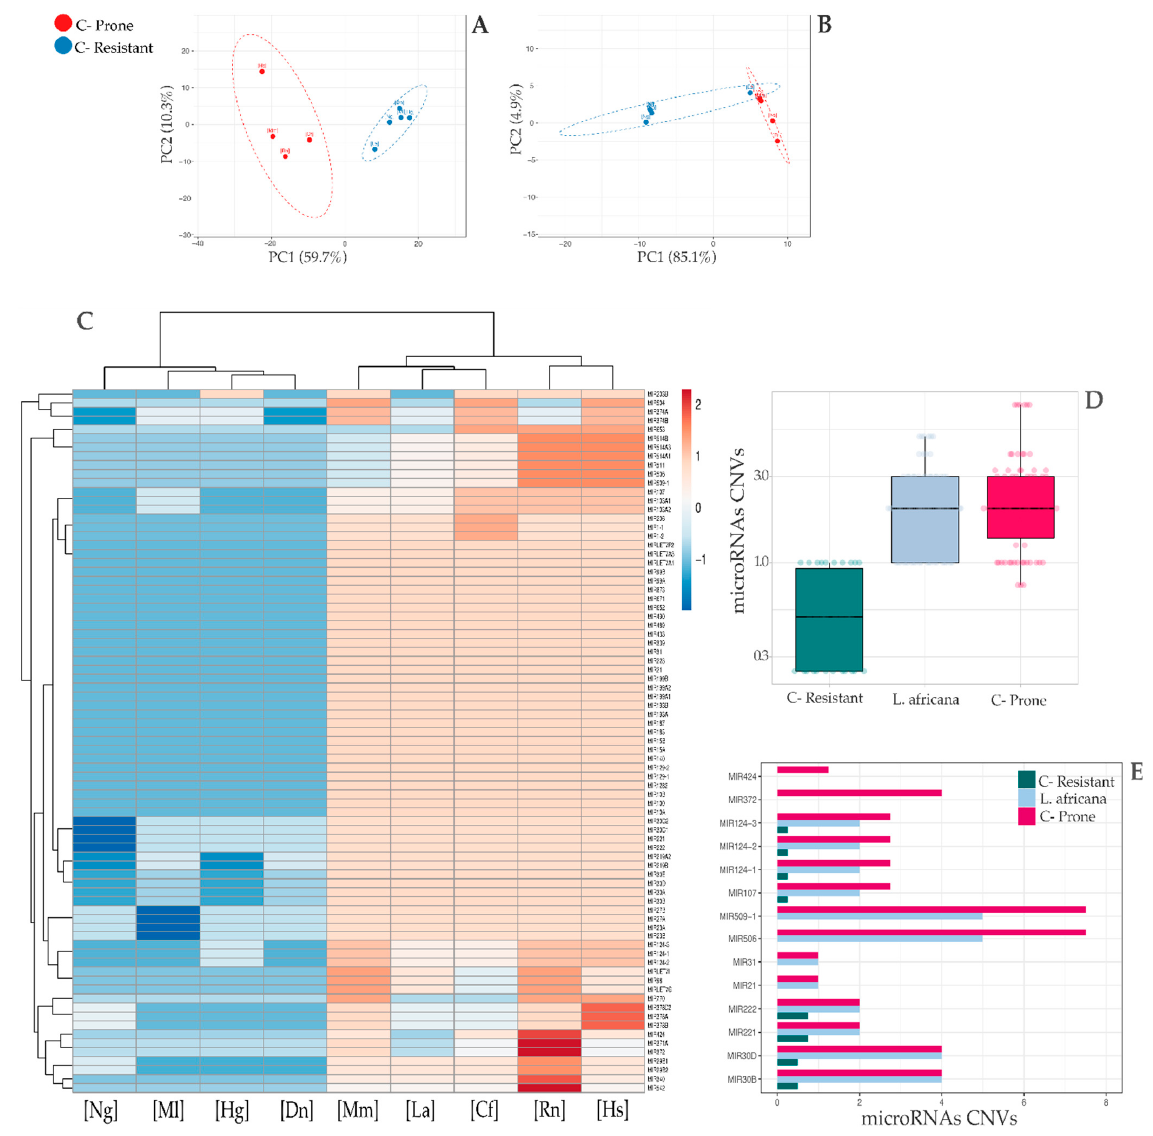
Figure 2. ( A ) PCA based on the CNVs of all the significant genes. ( B ) PCA based on the CNVs of the significant microRNAs subset. Both plots show a dichotomy between cancer-resistant (blue) and cancer-prone species (red). ( C ) Heatmap of the significant microRNAs, clustered with Euclidean distance and complete linkage. ( D , E ) Bar and box plots of the significant microRNAs CNVs in cancer-prone species, cancer-resistant species and Loxodonta africana . The microRNAs repertoire of Loxodonta africana seems to reflect the cancer-prone miRNAs copy number alteration landscape, rather than the one typical of the cancer-resistant organisms. In the box plots, the Y -axis scale was changed to log one. The boxplots are built considering the average number of copies of each gene in the two different target groups.